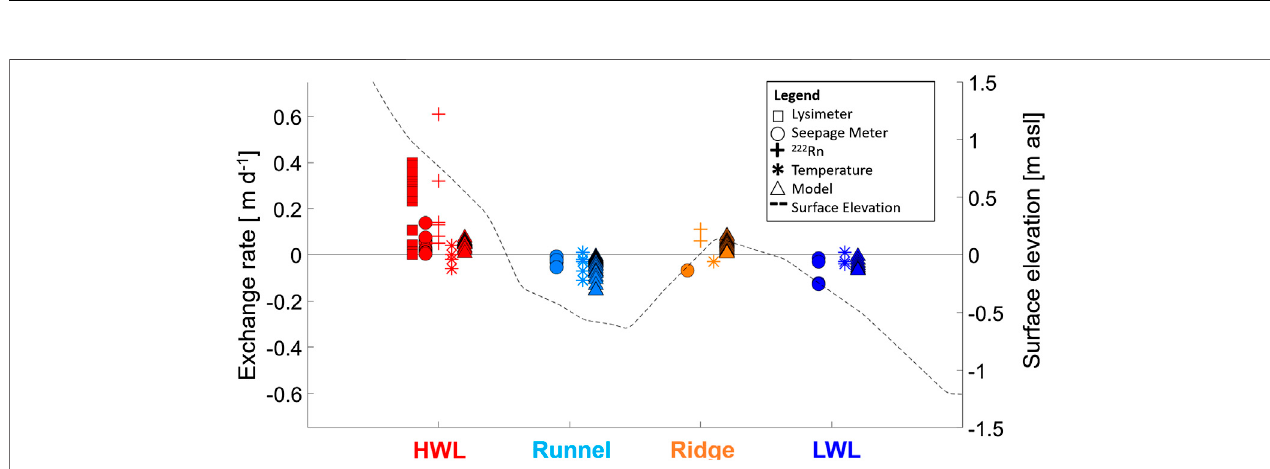
FIGURE 4 | Comparison of all measured exchange rates across respective in- or ex fi ltration zones (HWL (cid:2) red, Runnel (cid:2) light blue, Ridge (cid:2) orange, LWL (cid:2) blue). Thedifferentmethodsareindicatedwithsquares(lysimeters),circles(seepagemeters),crosses( 222 Rn),andstars(temperaturesensors).Modelresultsarealsoincluded (triangles). The exemplary surface elevation from October 2016 is added to visualize the principal zone distribution along the cross-section.